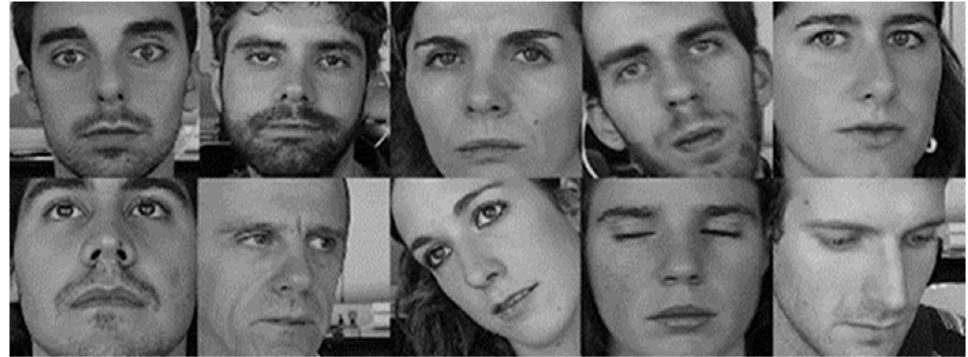
Figure 14. Sample photos from the dataset formed to test the overall success of SECS (first line: “Engaged”; second line: “Not Engaged”).